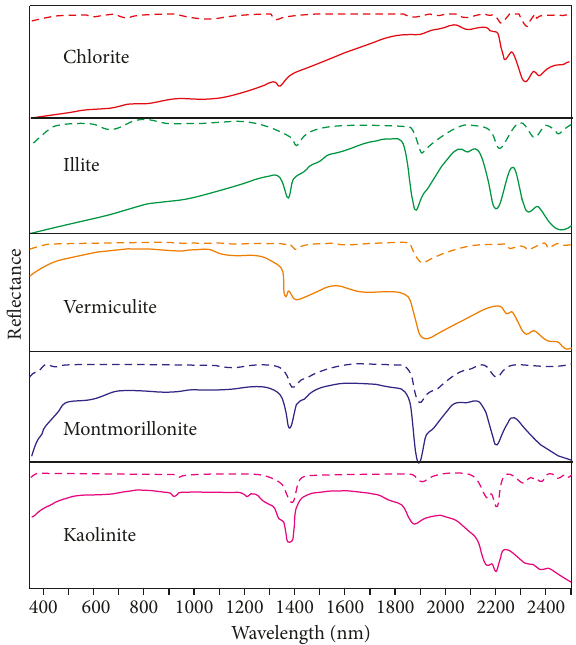
Figure 4: Raw and continuum-removed spectra of five common clay